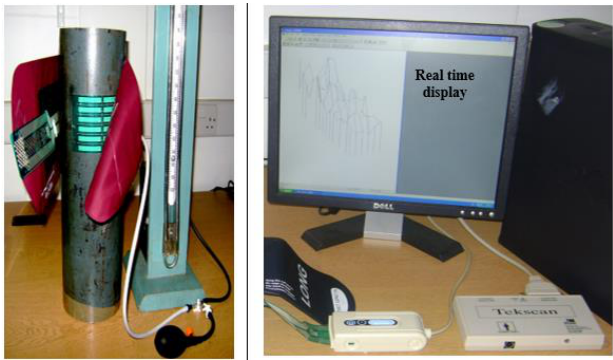
Fig. 2. Experimental setup for measurement of pressure at interface of cuff and metal cylinder